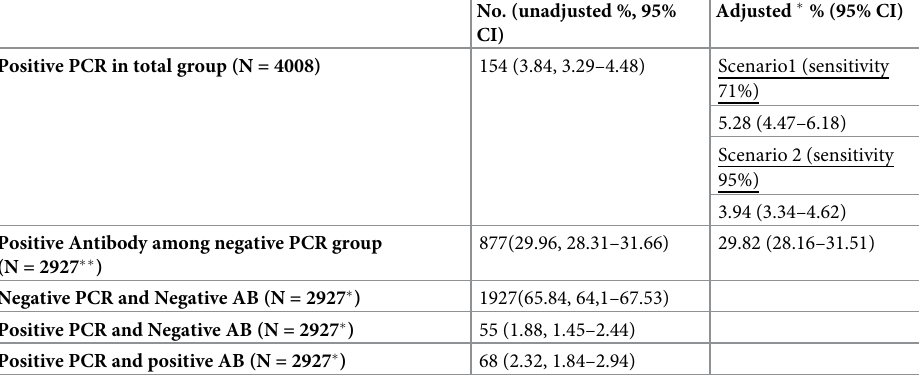
Table 2. Results of SARS-CoV-2 screening by PCR and total antibody.